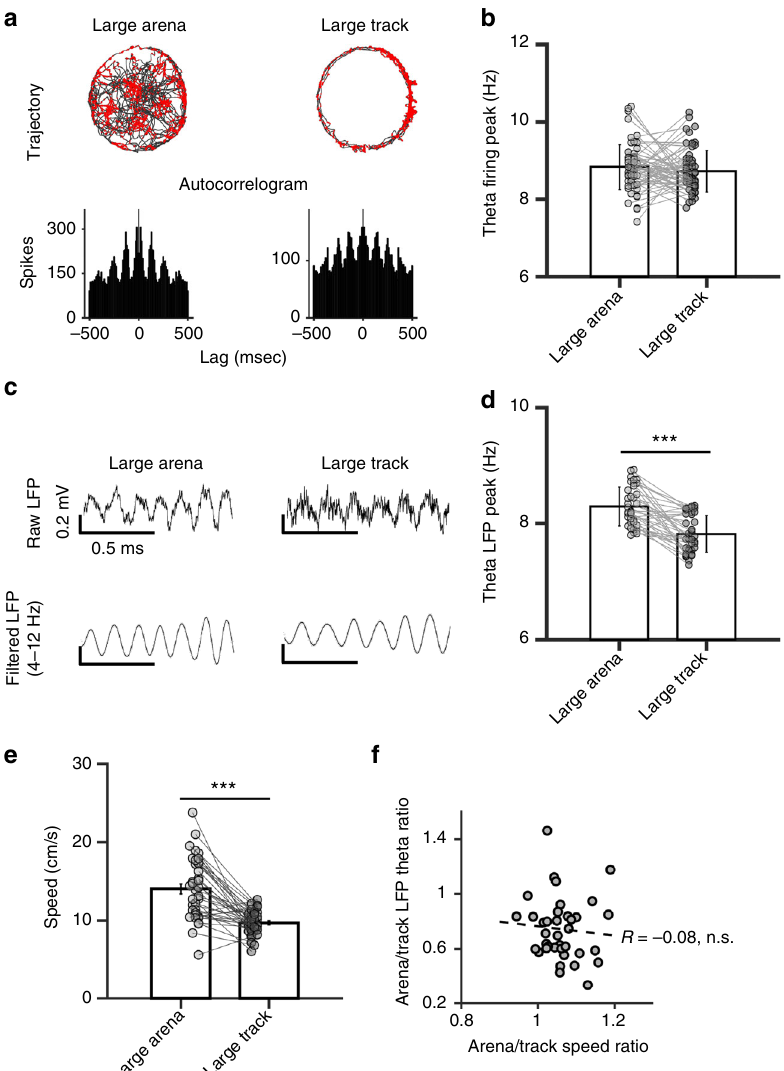
Fig. 6 Theta rhythm in the track. a Autocorrelograms of the fi ring activity from one grid cell recorded in the arena and the track. Top row: trajectory with spikes locations. Bottom row: autocorrelogram of fi ring in 500 millisecond lags. b Average peak frequency (±SD) in the theta band (4 – 12 Hz) of the grid cell autocorrelogram. c Example of raw (top row) and fi ltered (4 – 12 Hz, bottom row) LFP recorded in the arena and the track. d Average peak frequency (±SD) in the theta band of LFPs recorded in the arena and the track. *** p < 0.001, paired t -test. e Average animal speed (±SEM) in the arena and the track. *** p < 0.001, paired t -test. f Scatterplot showing the relation between the arena/track speed ratio and the arena/track LFP theta peak ratio; the Pearson correlation coef fi cient ‘ R ’ is indicated with its signi fi cance